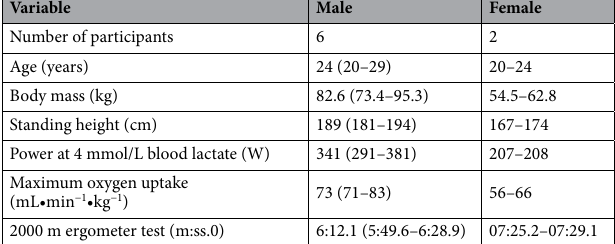
Figure 1. Study design. P4 [BLA] mechanical power output at 4 mmol/L blood lactate concentration;